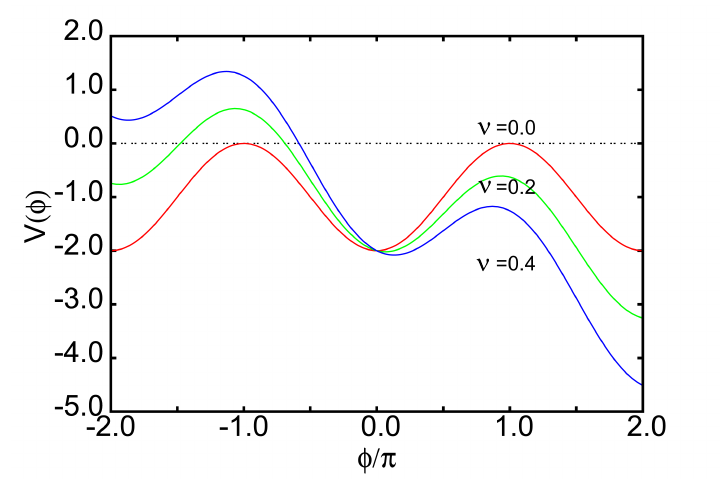
Figure 4. Plot of the potential function V ( φ ) = 1 − cos φ + νφ for ν = 0.0, 0.2 and 0.5. Note that ν > 0 (denoted with the dashed line) makes the potential assymetric with respect to the axis φ = 0.